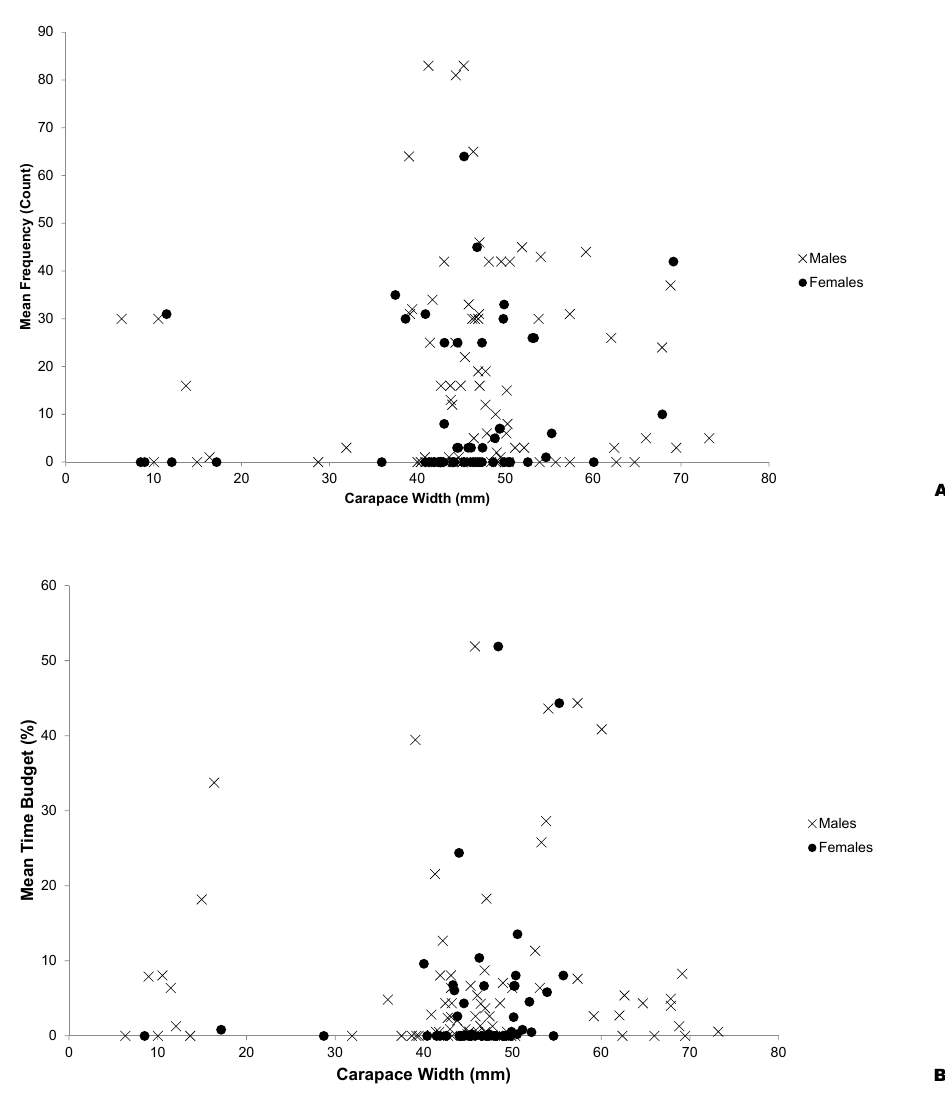
Figure 1. Relationship between grooming frequency and grooming time budget by carapace width (mm) for males and females in 30-min isolation observations (N=142). A. Mean grooming frequency by carapace width for males and females; no relationship between number of times individuals groomed and their body size (R 2 =0.003, y=.092x+10.3). B. Mean grooming time budget by carapace width for males and females; no relationship between time spent grooming and body size (R 2 =0.005,